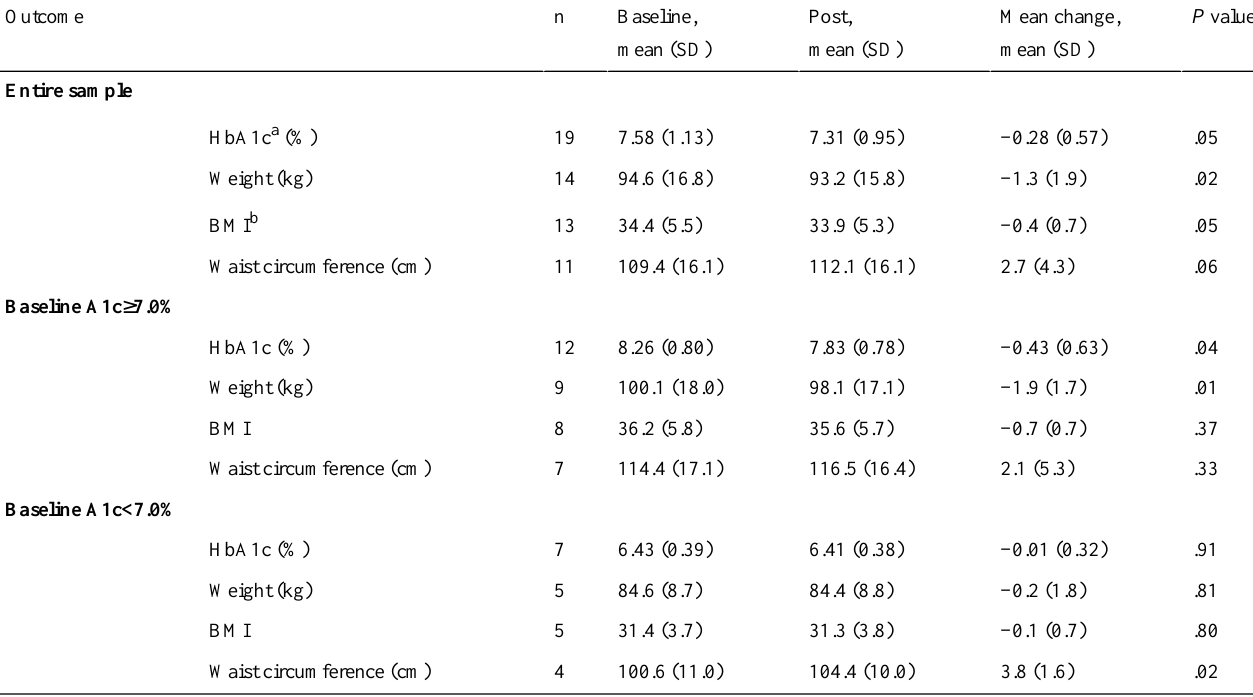
Table 2. Change in outcomes of patients participating in the Health Coach intervention.